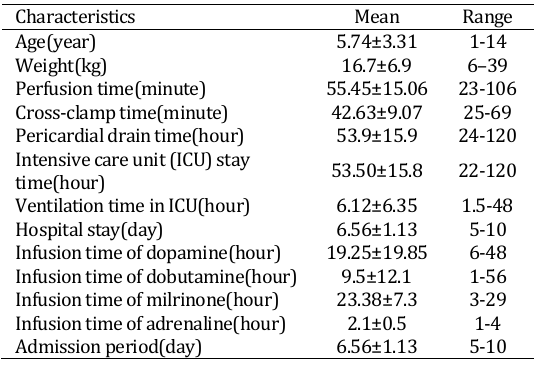
Table 1. Patients’ preoperative , operative, and postoperative characteristics Characteristics